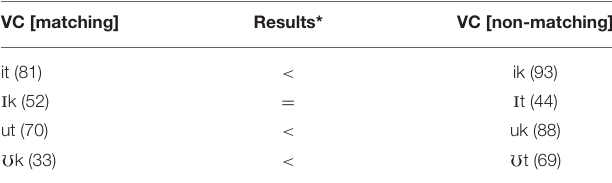
TABLE 5 | Intelligibility of vowels in syllables according to approximate match or non-match of rhymes in English and Cantonese.